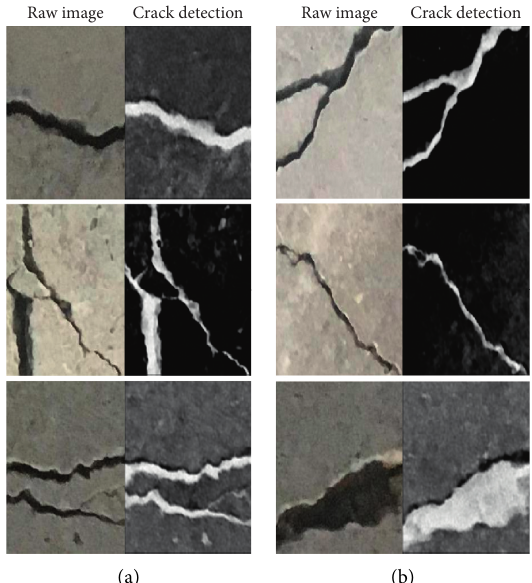
Figure 6: The capability of the CNN model in crack detection for several samples (based on the contrast between the background and the cracks).